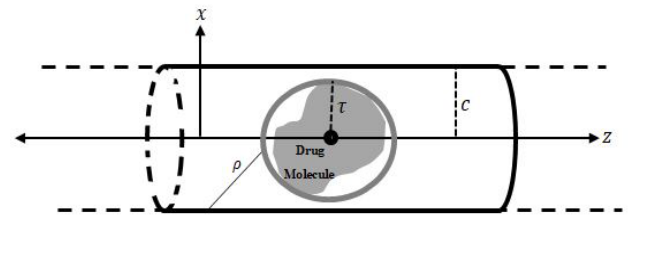
Figure 1. Optimized geometry of the drug molecule encapsulated into the